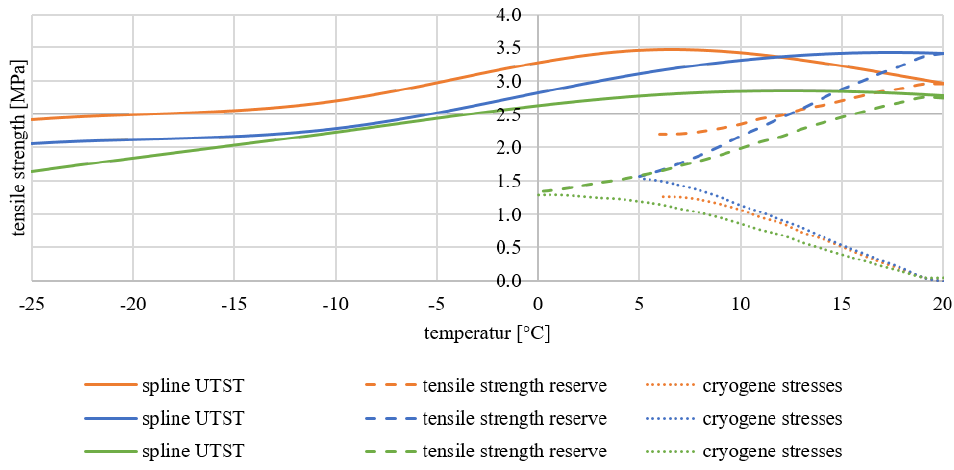
Figure 10. Results of the UTST and TSRST: RAP0 (orange), RAP25 (blue), RAP50 (green). In Figure 10, it was recognized that in all TSRST of the variants RAP0 (orange), RAP25 (blue) and RAP50 (green), the resulting cryogenic stresses lead to early material failure. The samples were already damaged at temperatures starting at about 5 ◦ C (RAP0 and